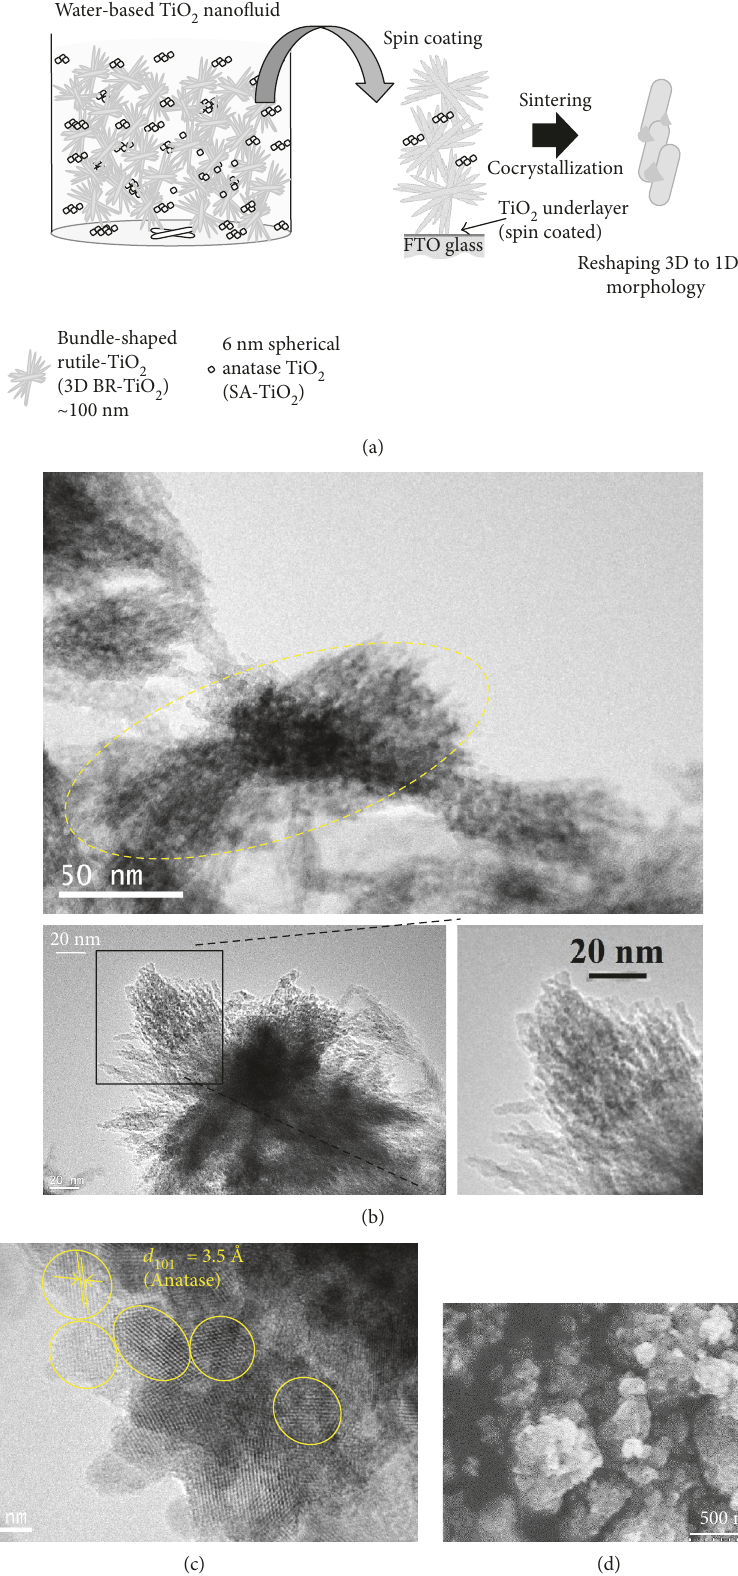
Figure 1: (a) Schematics of BR-TiO and SA-TiO deposited on FTO substrate above the sublayer and subsequent sintering process. (b) TEM 2 2 images of BR-TiO . (c) A TEM image of SA-TiO . (d) A SEM image of SA-TiO 2 2